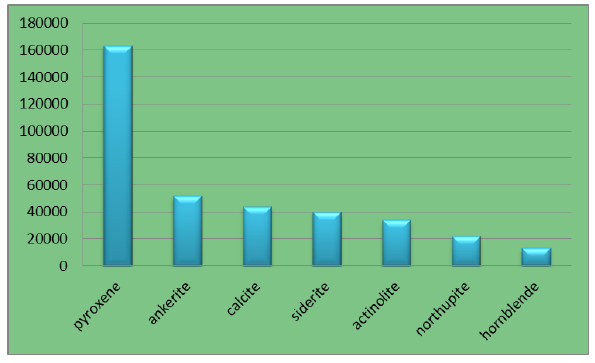
Figure 2. Mineral abundance in Jezero